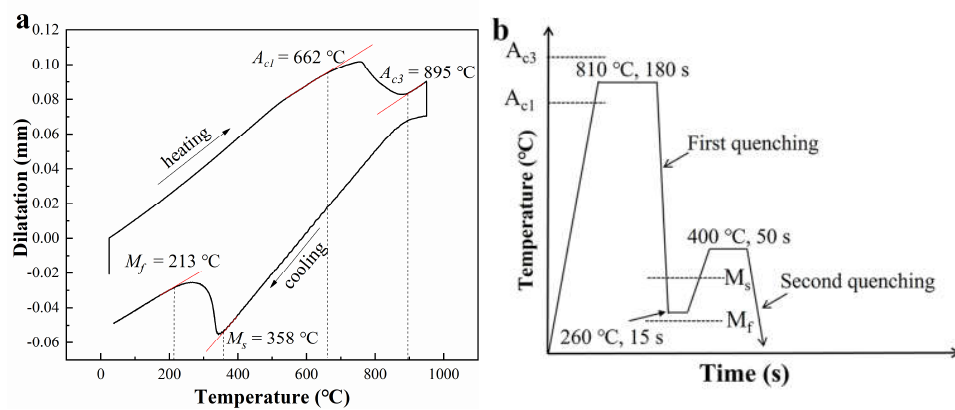
Figure 1. ( a ) Expansion curve of hot-rolled 0.2C–1.7Si–1.9Mn wt% steel during heating and cooling processes and ( b ) Q&P treatment adopted in this study.